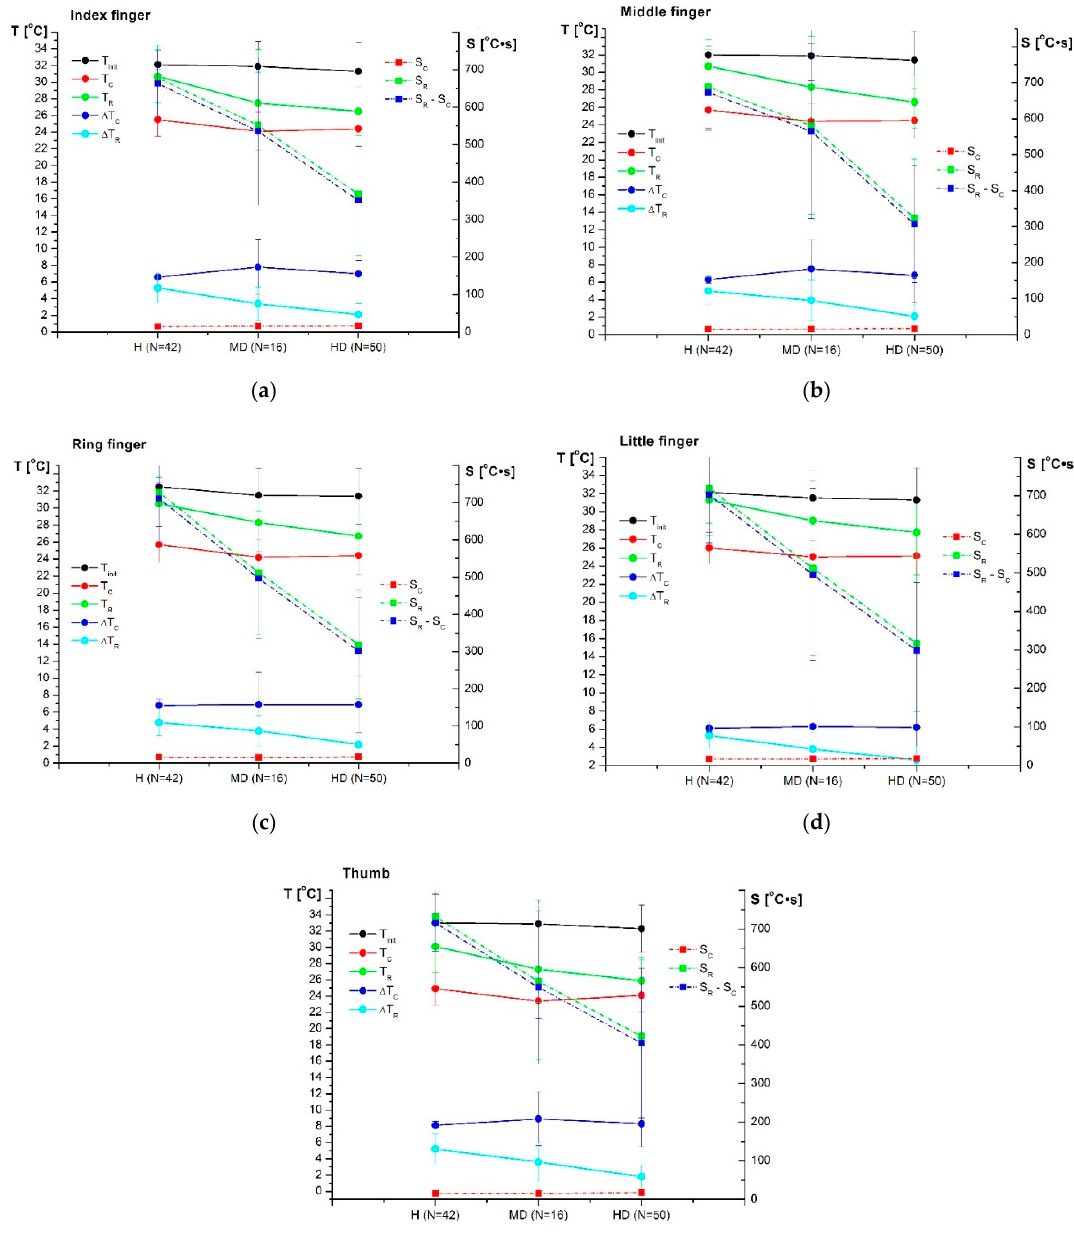
Figure 5. Mean (SD) value of thermal imaging outcomes for high and moderate disease activity compared to healthy subjects: ( a ) Index finger; ( b ) middle finger; ( c ) ring finger; ( d ) little finger; ( e ) thumb.